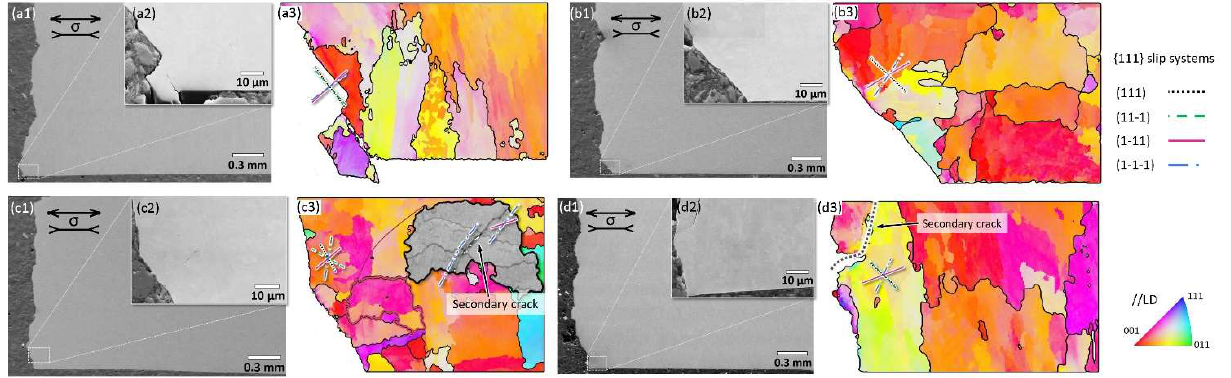
Figure 12. Secondary electron SEM micrographs and IPF coloring map superposed with grain boundary plots of the crack initiation regions of ( a1 – a3 ) E1 specimen and ( b1 – b3 ) E2 specimen, tested at σ a = 545 MPa; ( c1 – c3 ) E1 specimen and ( d1 – d3 ) E2 specimen, tested at σ a = 700 MPa. The fatigue loading directions are parallel to the horizontal direction. The family of {111} traces of crystallographic planes are indicated.